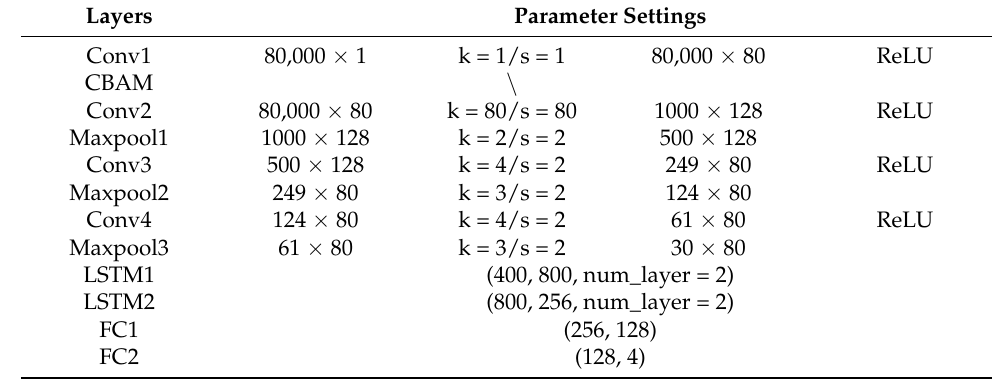
Table 1. Network parameter setting.